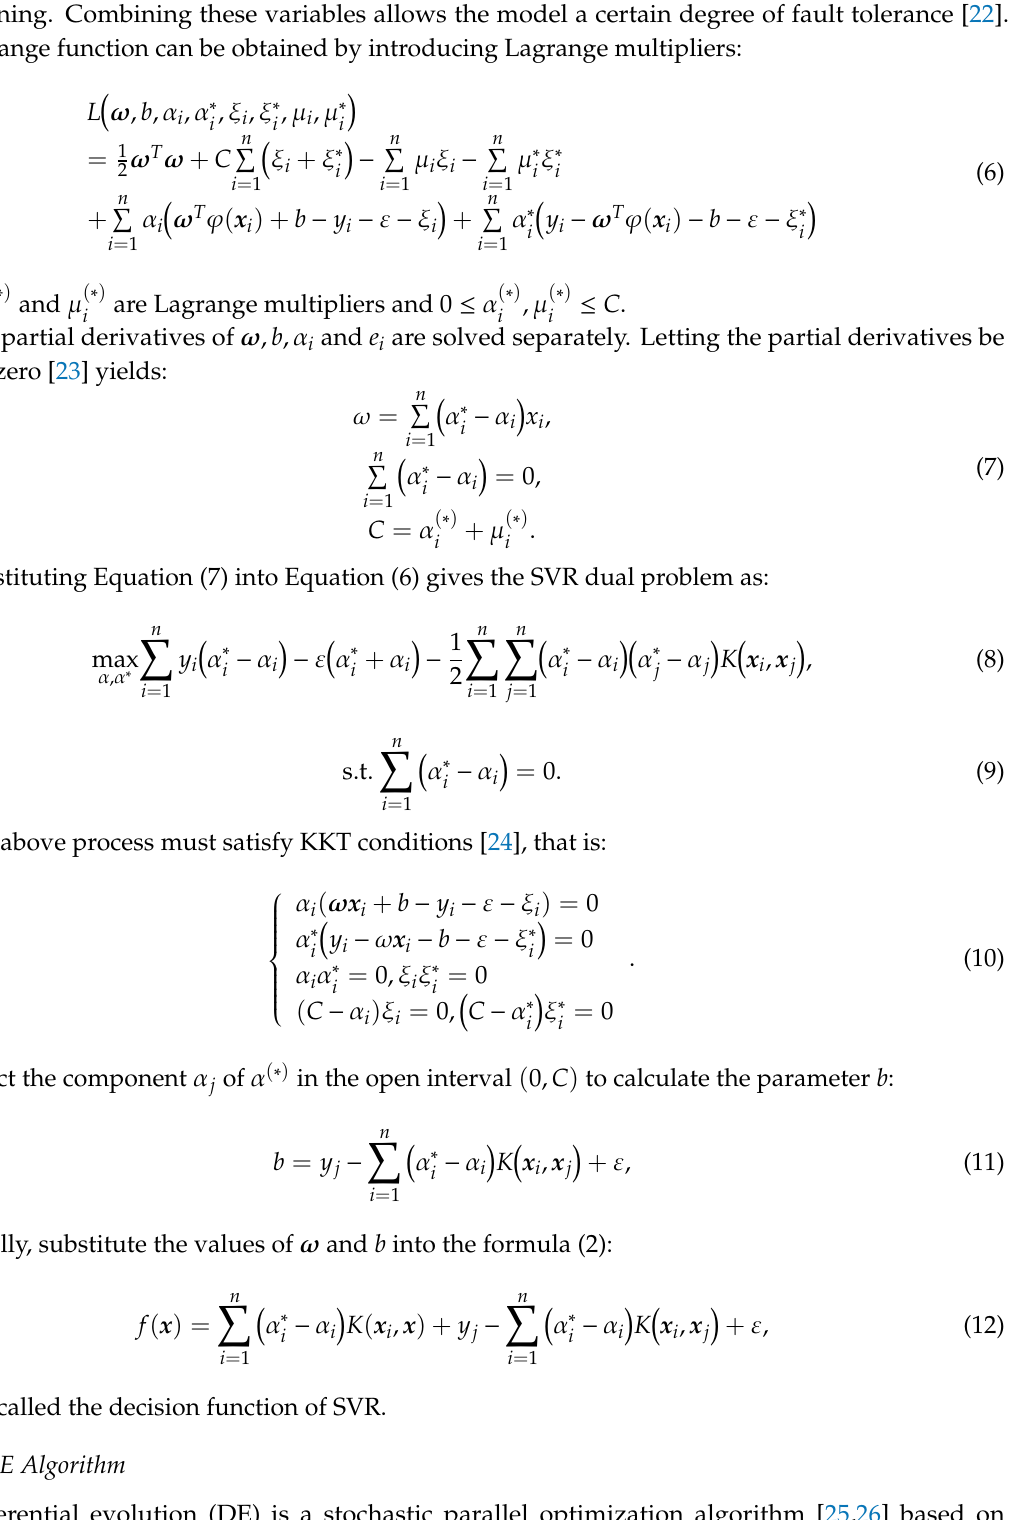
Di ff erential evolution (DE) is a stochastic parallel optimization algorithm [25,26] based on population di ff erences proposed by Storn and Price in 1997 [27] on the basis of evolutionary ideas such as the genetic algorithm. DE solves optimization problems by imitating the heuristic